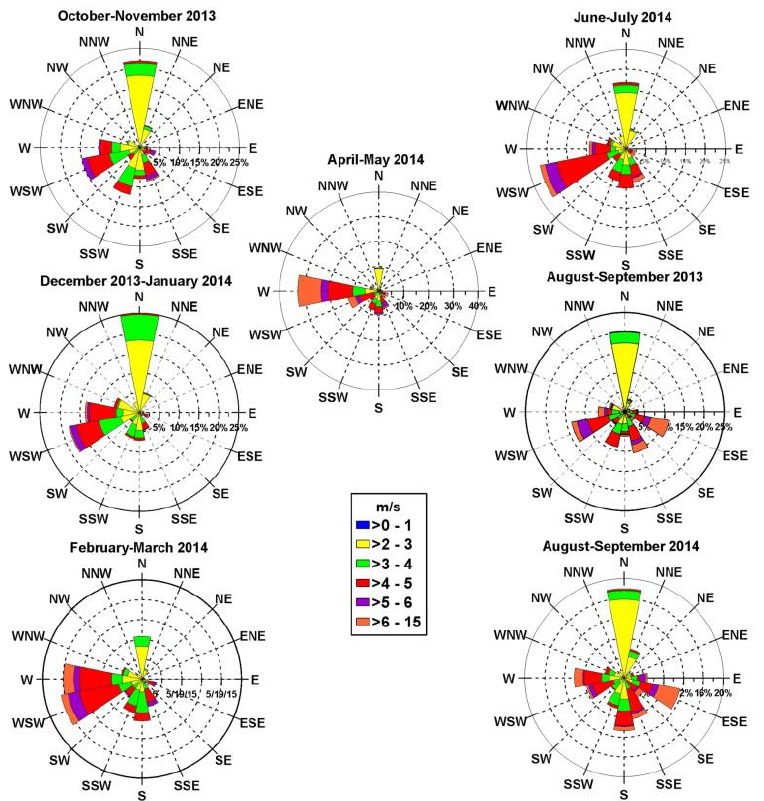
Figure 5. Wind roses recorded every two months from the Manzanillo International Airport meteorological station. Table 3. Main hydrometeorological events drove morphodynamic changes. Details below are from the National Hurricane Center, National Service Weather.